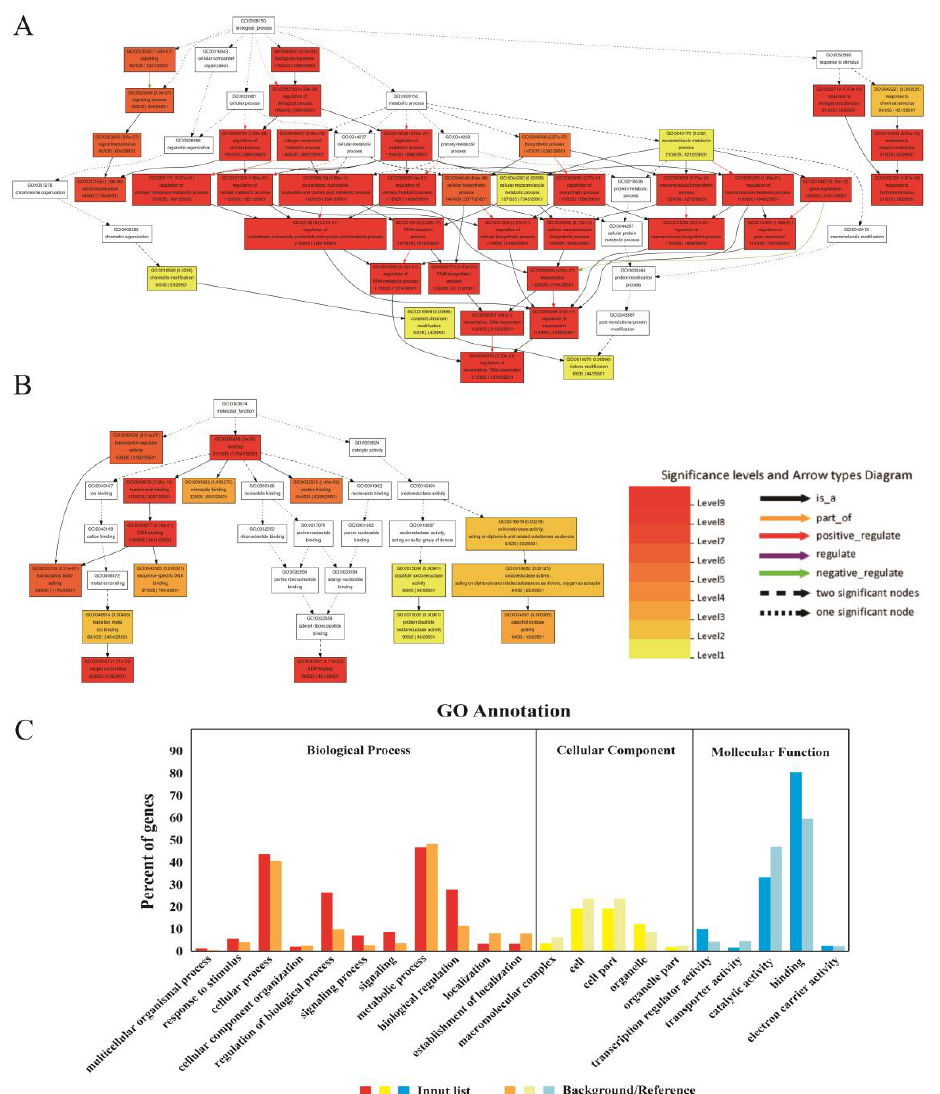
Figure 8. Agrigo Enrichment Analysis of target genes. AgriGO enrichment at false discovery rate (FDR) < 0.01 level, classification of genes by GO annotation enrichment, resulting in three major types of biological processes, cellular components and molecular functions. ( A ) Biological process. ( B ) Molecular function. ( C ) GO analysis of targets of known and new miRNAs in this study. The dark column represents the enrichment of miRNA target genes in the GO terminology. Light column represents the percentage of total annotated soybean genes mapped to GO terms.